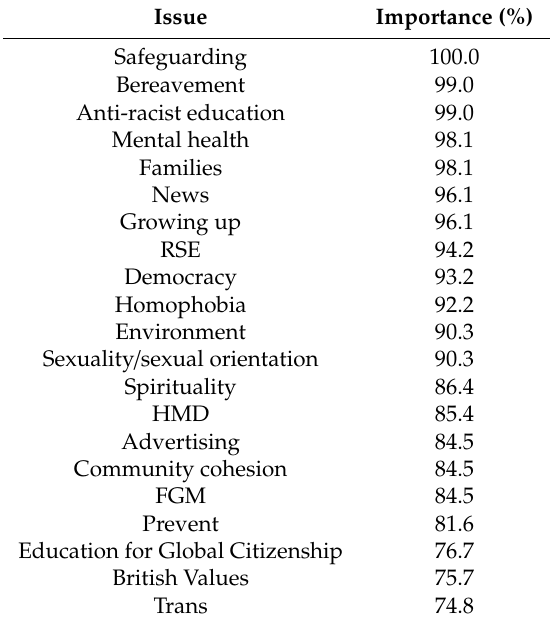
Table 5. Personally, which three areas are important to